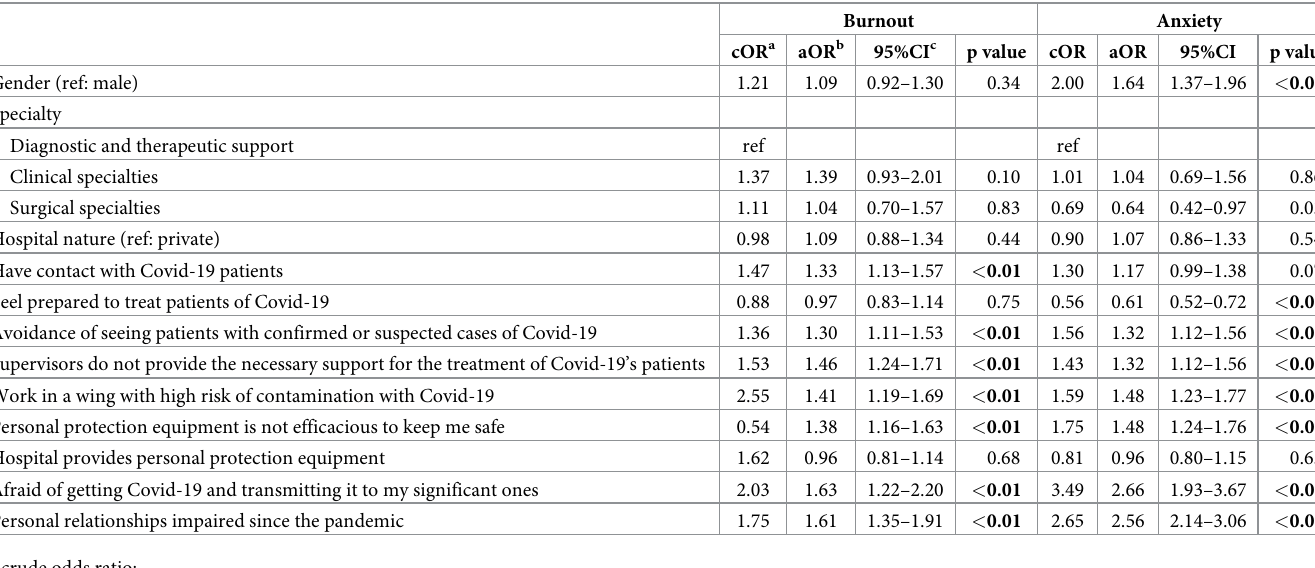
Table 2. Logistic regression model of burnout and anxiety symptoms among 3071 residents from Brazil,